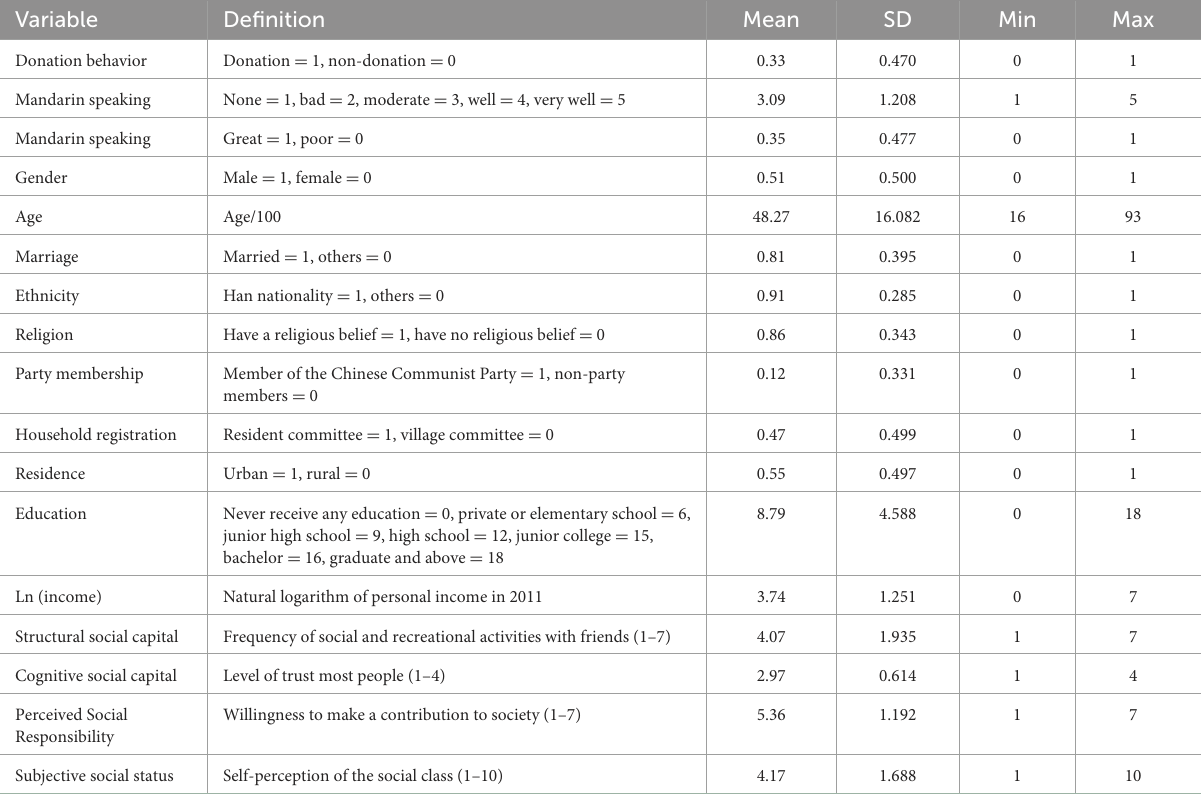
TABLE 1 The method of variable measurement and the result of descriptive statistics ( N = 5,171).